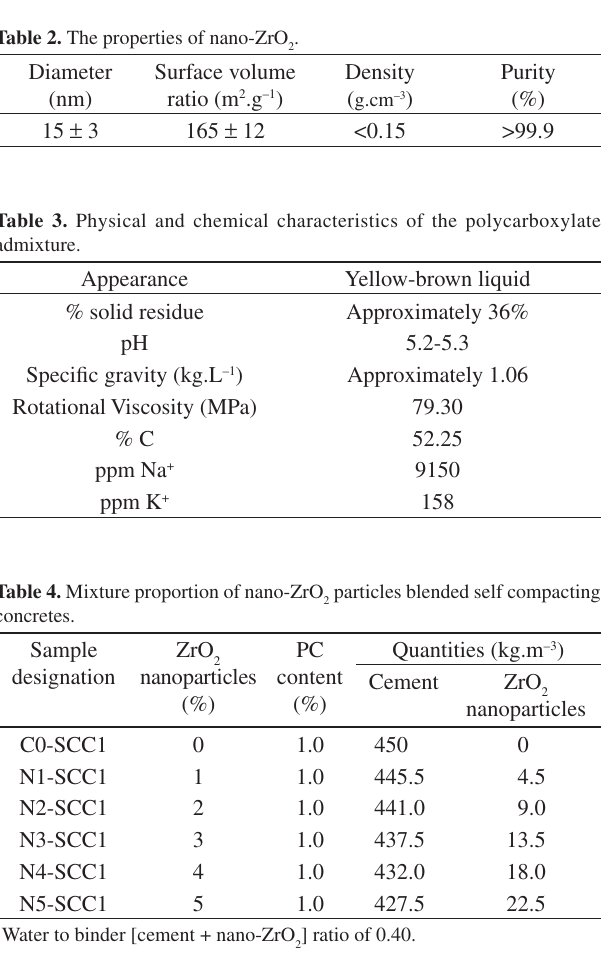
Table 2. The properties of nano-ZrO